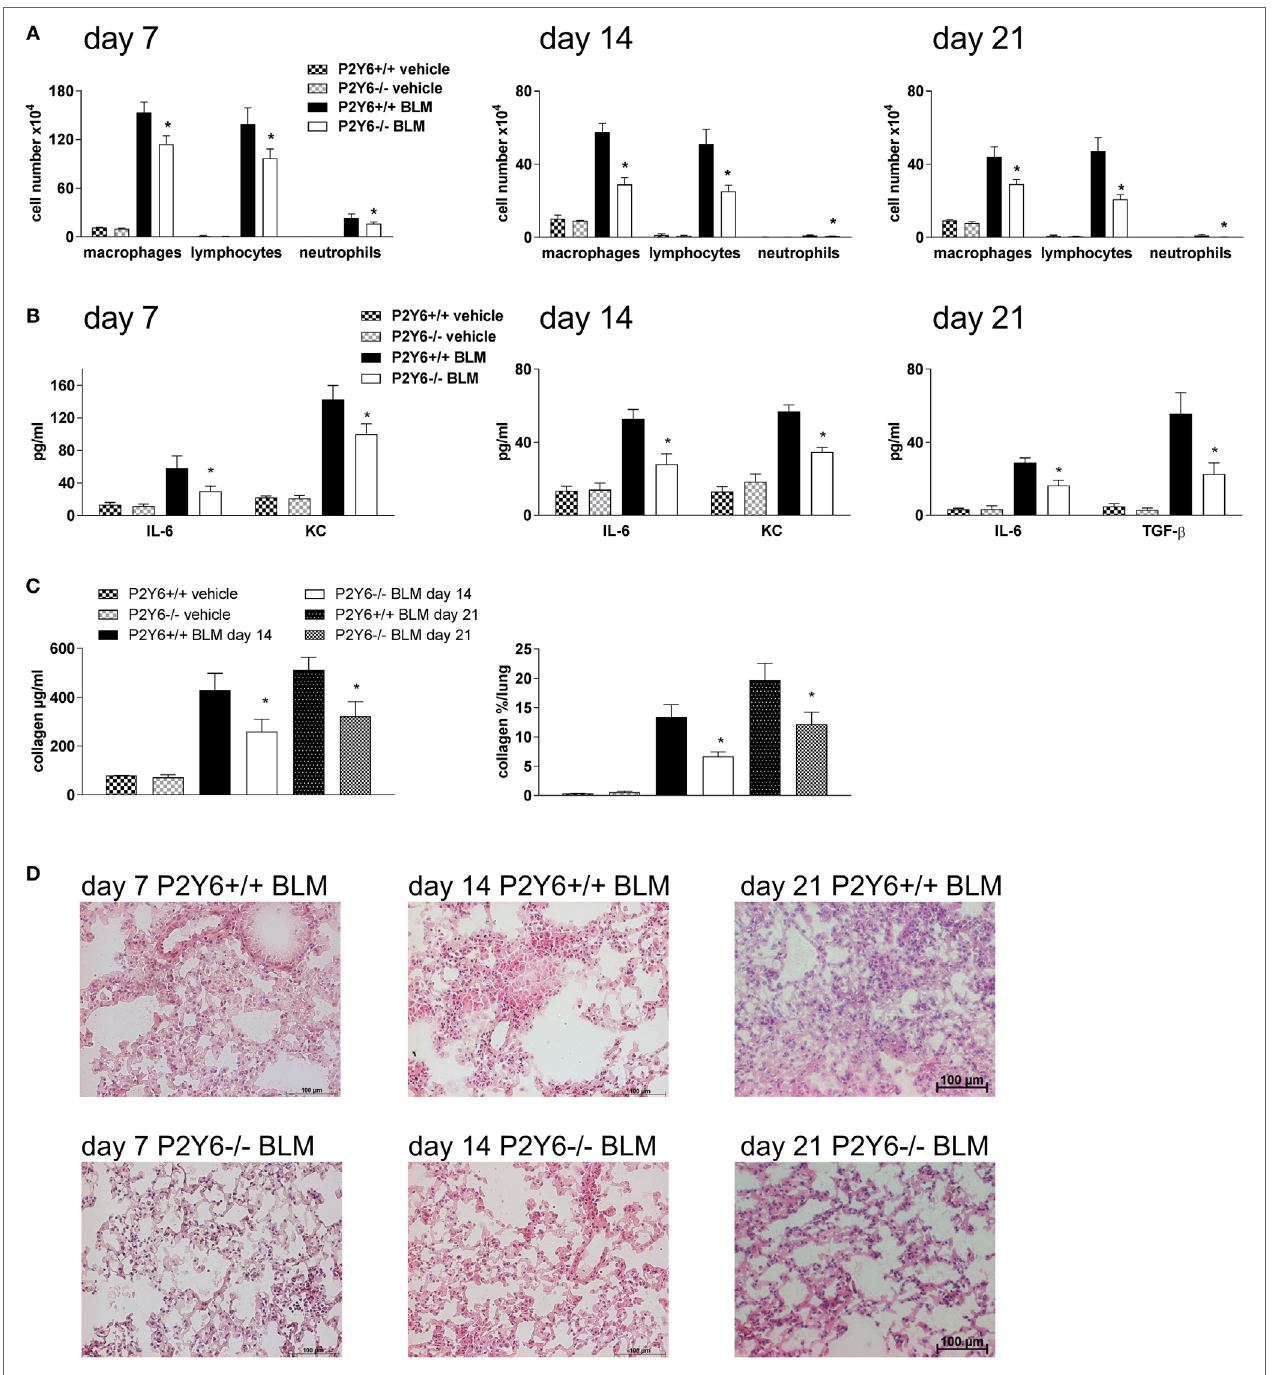
FigUre 4 | P2Y 6 R in bleomycin-induced pulmonary fibrosis. P2Y 6 R-deficient or wild-type (WT) mice received an i.t. injection of BLM or vehicle on day 0 and were killed 7, 14, or 21 days later. Total and differential cell counts of the BALF were performed (a) . BALF cytokines were measured by ELISA (B) . Collagen contents of the BALF were quantified by Sircol assay [ (c) , left panel] or on histological lung slides [ (c) , right panel]. Representative histological staining of lung slides (D) . n = 4–14 per group. * p < 0.05 BLM-treated P2Y 6 R-deficient compared to BLM-treated WT animals at the same time